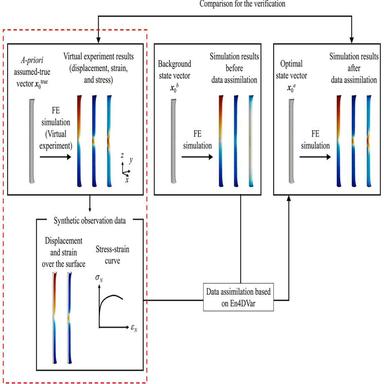
Schematic diagram of the numerical experiments to verify the estimated parameters using data assimilation based on En4DVar and evaluate the results of the simulation using the estimated parameters.